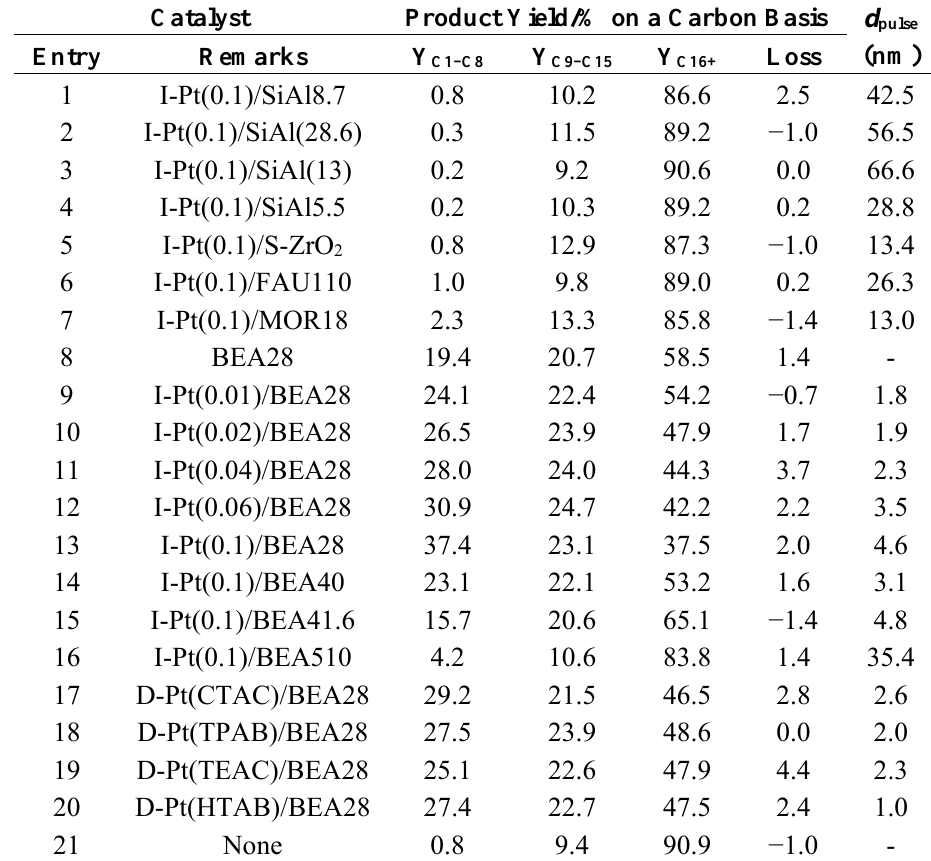
Table 4. Hydrocracking reaction over Pt-loaded catalysts and Pt particle size by CO chemisorption.